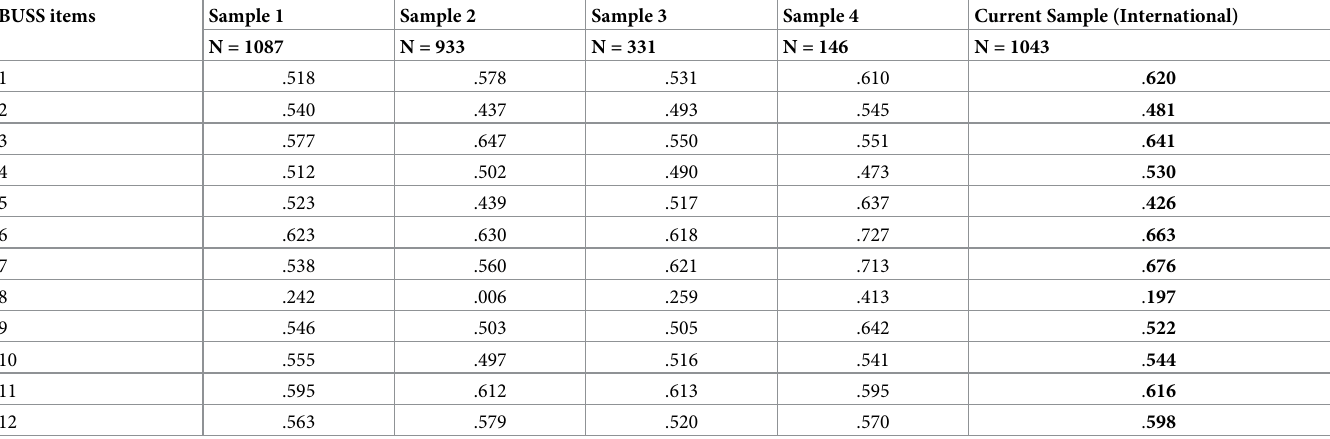
Table 2. Correlation between each item of BUSS and total BUSS score from several studies. BUSS